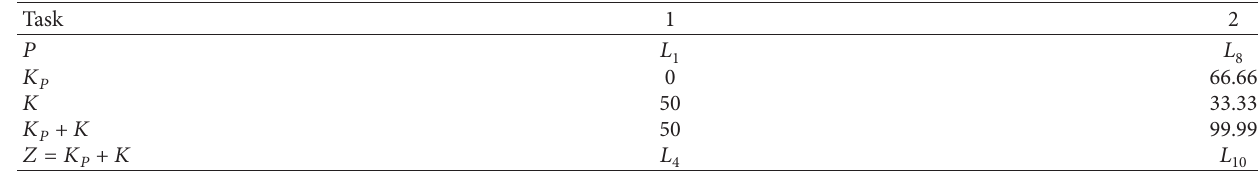
Table 5: Measurement